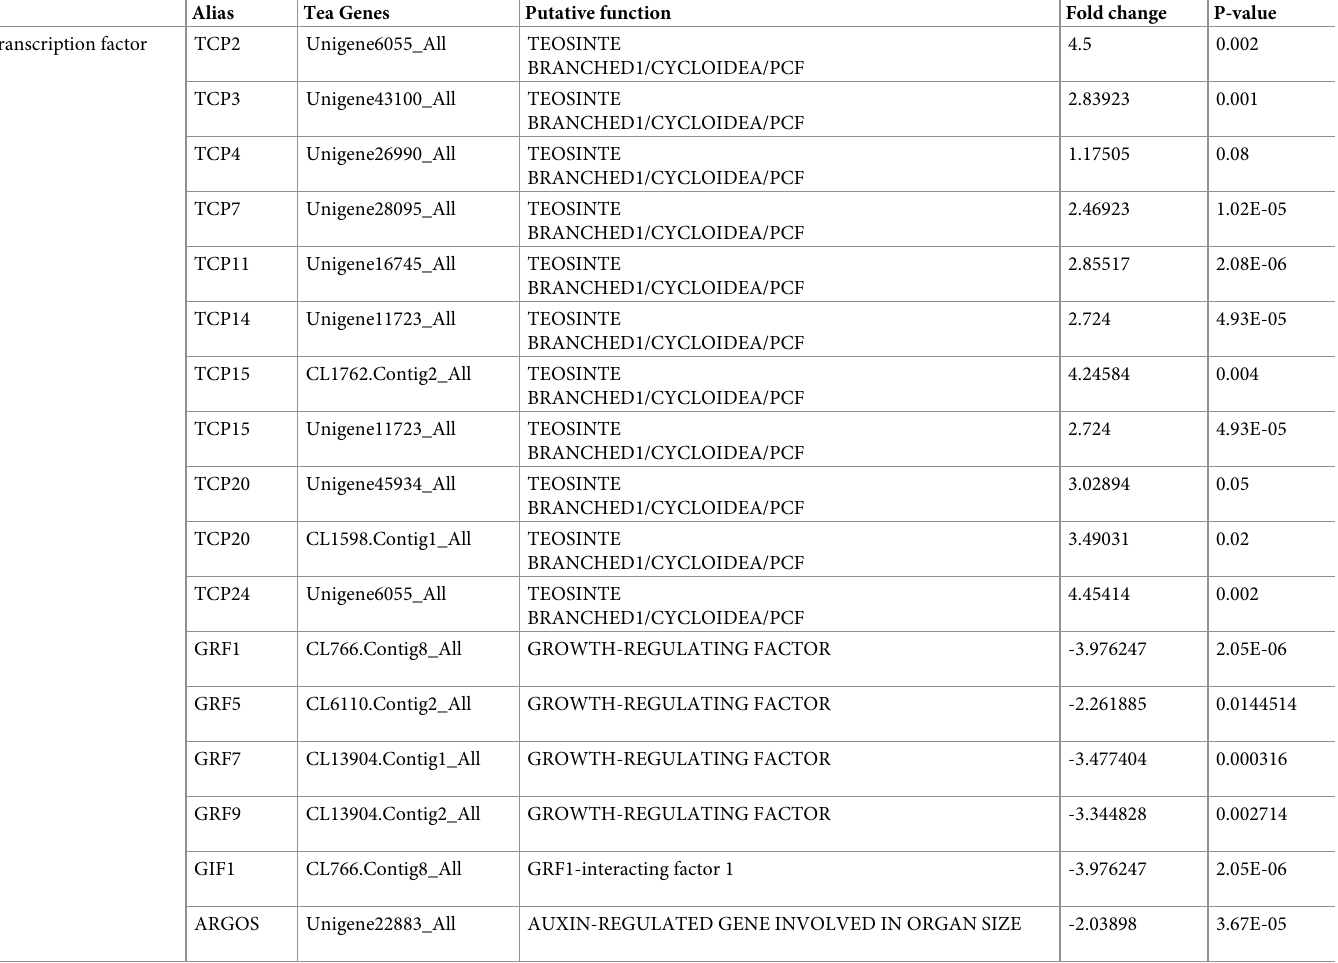
Table 4. Transcription factor identified in the DEGs involved in leaf developmental in diploid and